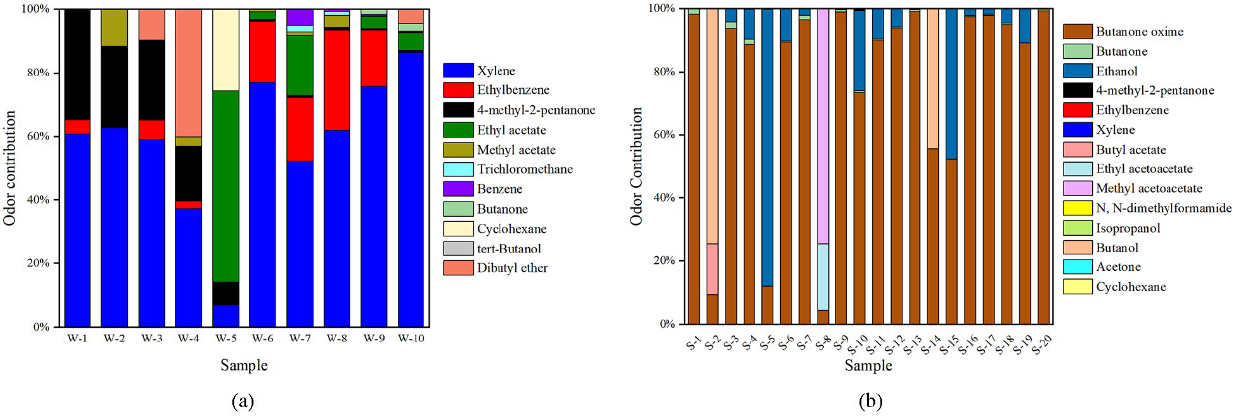
Figure 6. Odor contribution of volatile compounds emitted from white emulsion adhesives ( a ) and silicone adhesives ( b ).